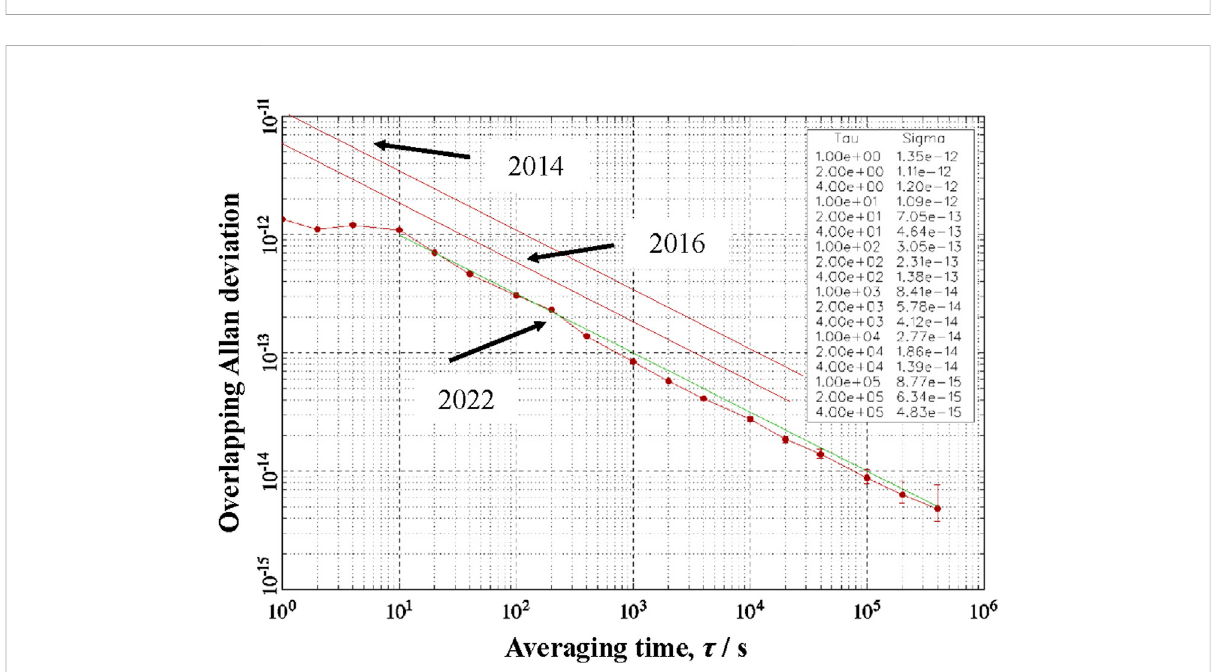
(cid:1) √ τ and in 2016, the short-term stability reached